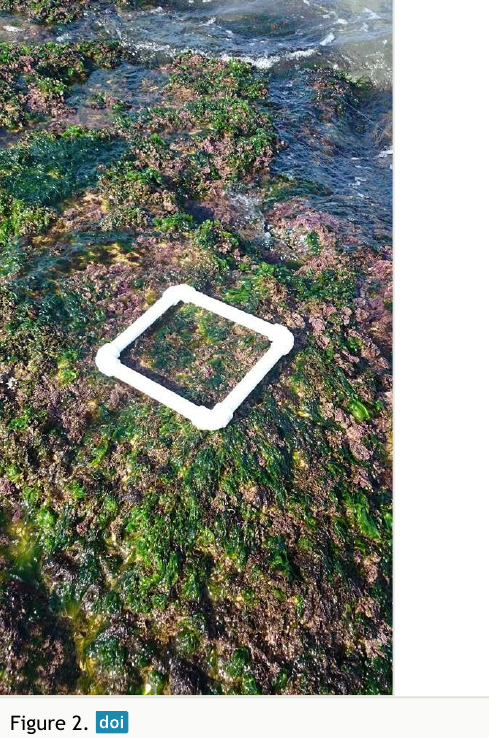
Figure 2. Quadrat used for sampling (20 × 20